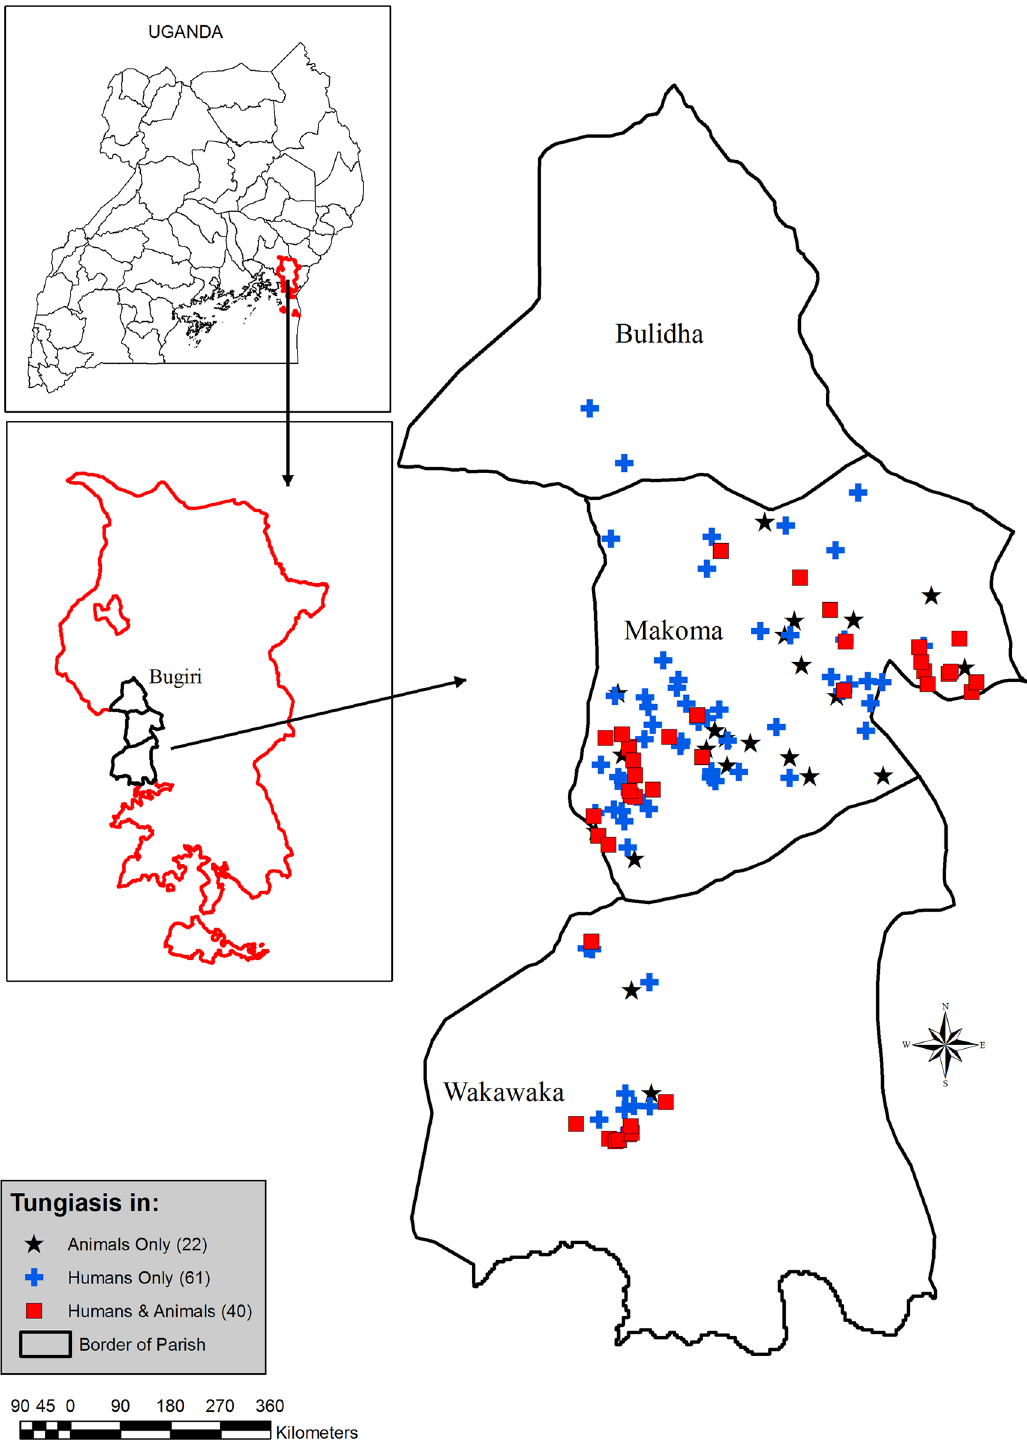
Fig 1. Map of study area and location of households with animal and/or human tungiasis. All study sites were located in the parishes Makoma, Wakawaka and Bulidha in the Bugiri district. Cases tended to cluster geographically.